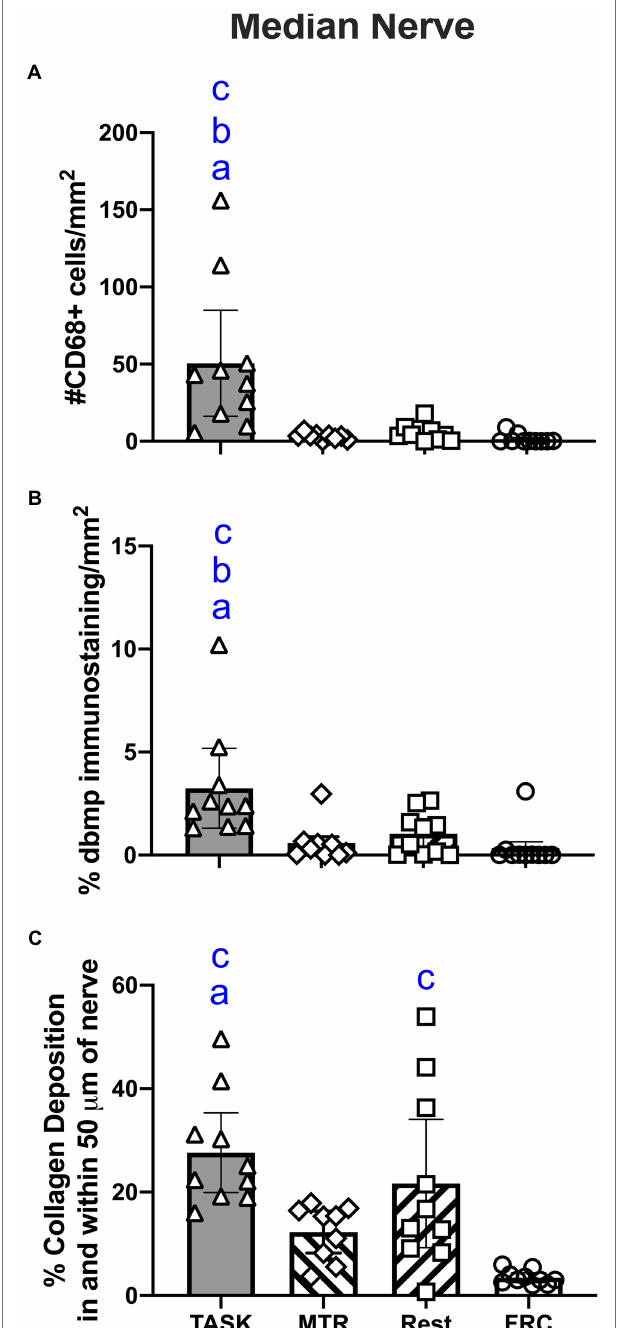
FIGURE 4 | Median nerve histomorphometry, at the level of the wrist. (A) Number of CD68+ macrophages. (B) Percent degraded myelin basic protein (dmbp) immunostaining in nerve. (C) Percent collagen deposition/ fibrosis in and around the nerve in Masson’s Trichrome stained sections. Symbols: a , b , and c : p < 0.05 each, compared to MTR, REST, and FRC groups, respectively. Mean ± 95% CI shown.